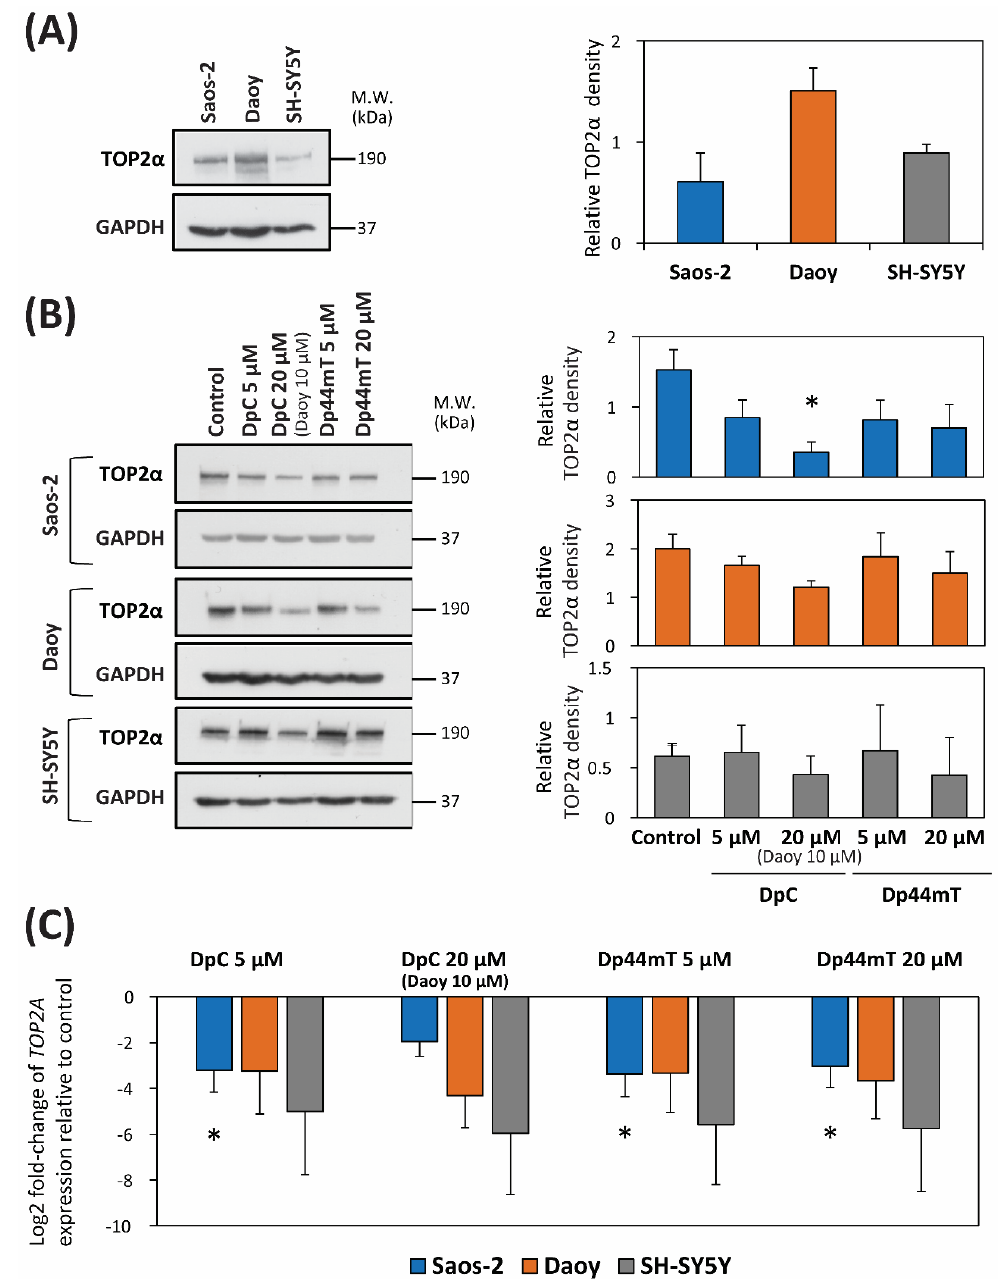
Figure 6. TOP2 α expression is down ‐ regulated at the ( A , B ) protein and ( C ) mRNA levels after incubation with either control medium, DpC (20 μ M; 10 μ M for Daoy), or Dp44mT (20 μ M) for 24 h/37 °C. ( A ) Western blot analysis of the TOP2 α level in untreated Saos ‐ 2, Daoy and SH ‐ SY5Y cells. GAPDH served as a protein ‐ loading control. ( B ) Western blot analysis of the TOP2 α level in Saos ‐ 2, Daoy and SH ‐ SY5Y cells after incubation with DpC or Dp44mT for 24 h. GAPDH served as a protein ‐ loading control. ( C ) The graph shows changes in the mRNA expression of TOP2A in Saos ‐ 2, Daoy and SH ‐ SY5Y cells after 24 h of incubation with DpC or Dp44mT. These data were obtained by RT ‐ qPCR. The levels of gene expression after thiosemicarbazone treatment are presented as the log 2 fold change in mRNA expression relative to that in the untreated control. GAPDH served as a reference control. For all experiments, expression was assessed in three biological replicates. The Western blots presented are from a typical experiment of three performed, while the quantitation of the blots is presented as mean ± SD (three experiments). These data were analyzed using the unpaired Welch’s t ‐ test followed by the Games ‐ Howell post hoc test. * ( p < 0.05) indicates significant differences compared to the respective control group.